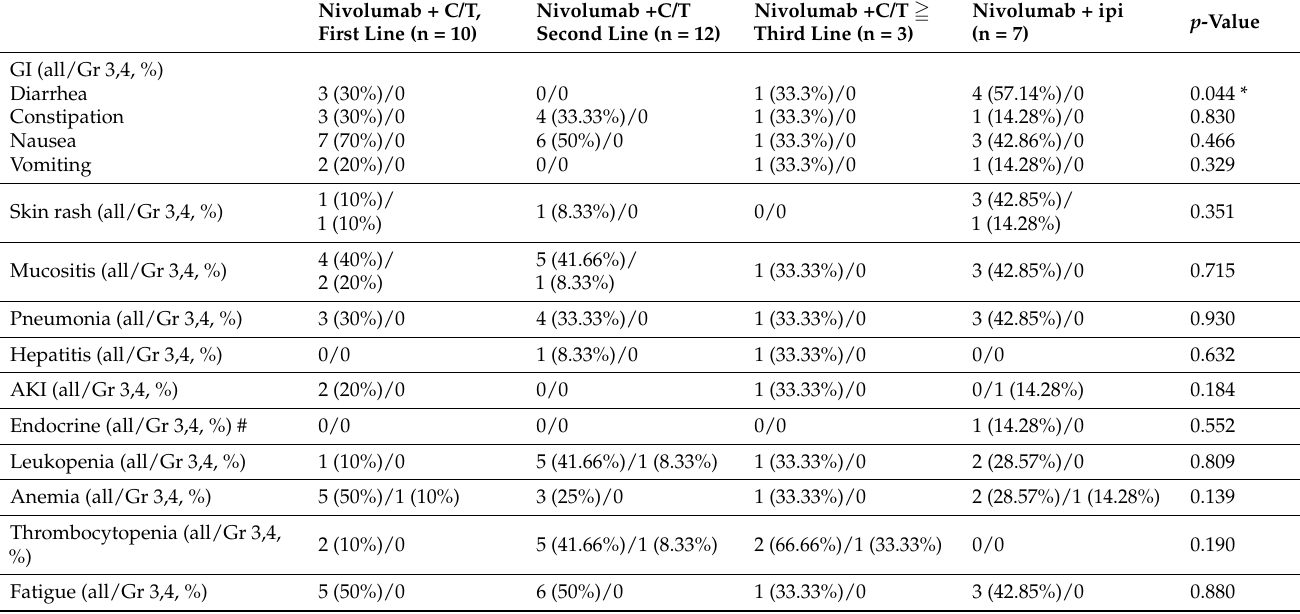
Table 5. Adverse effects in different lines of I/O